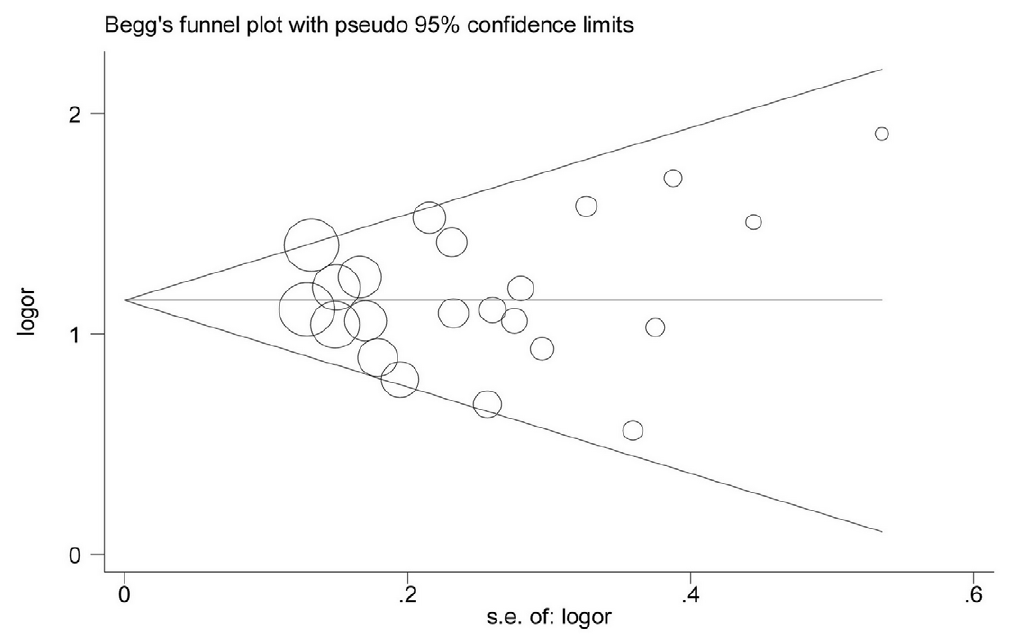
Figure 4. Begg’s funnel plot [ 17 ] (GA vs. GG) for the identification of publication bias in all studies.